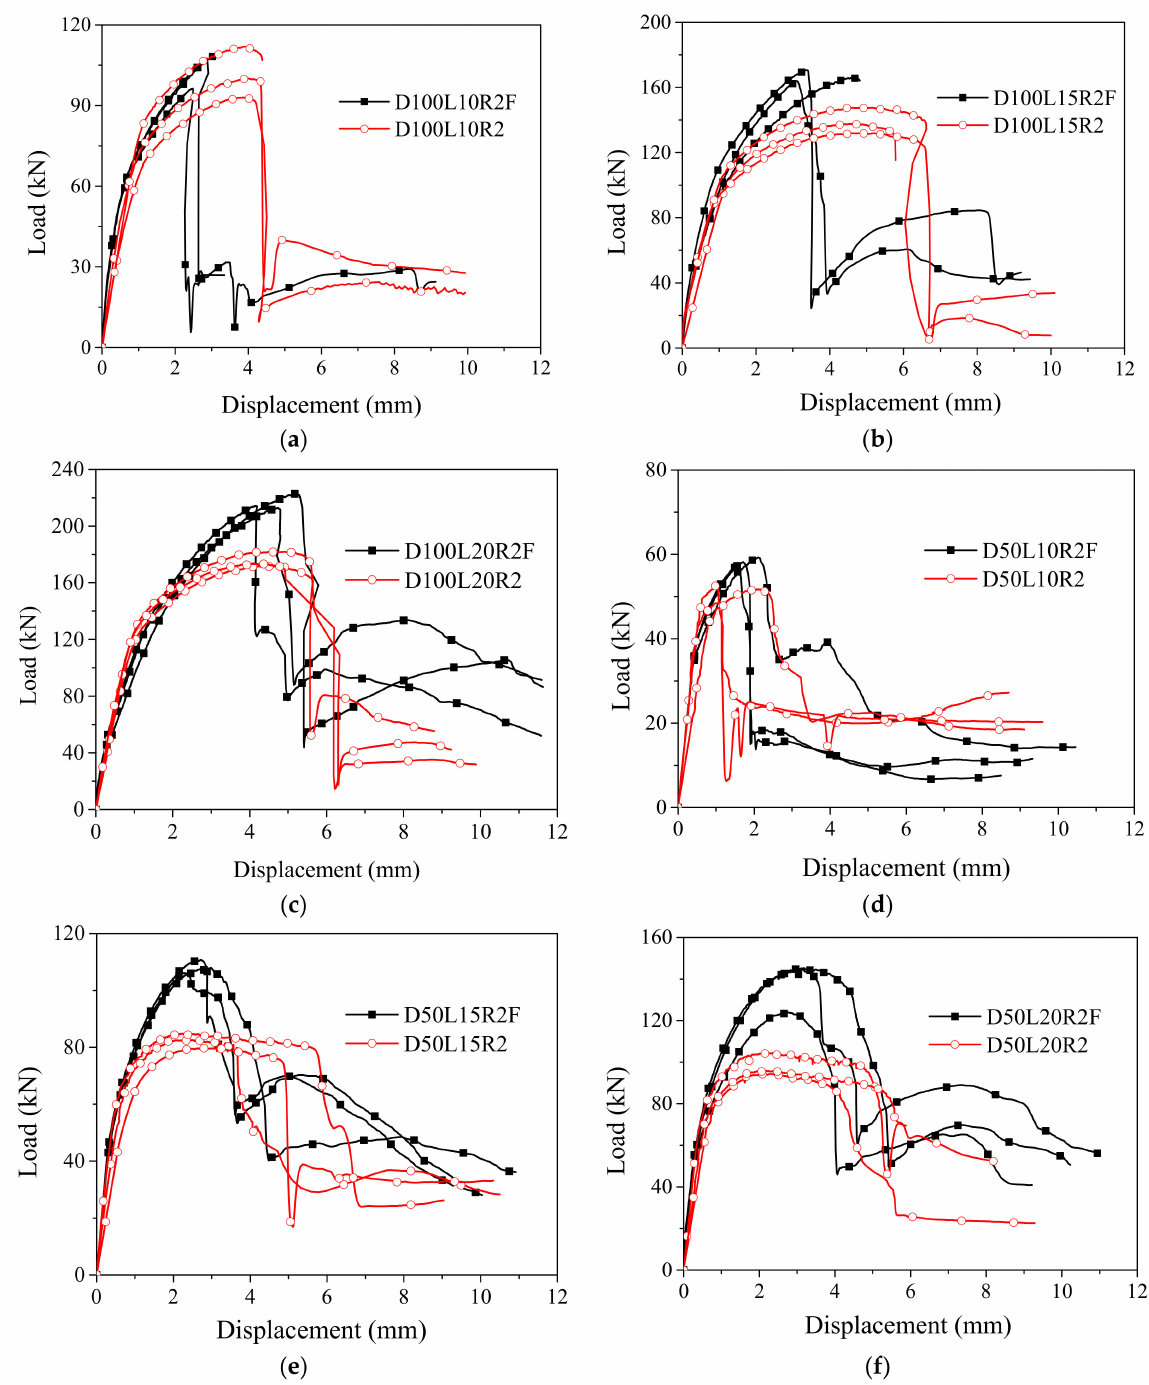
Figure 5. Comparison of load–displacement curves between foam-filled and unfilled bamboo com- posite tubes. ( a ) D100L10R2F; ( b ) D100L15R2F; ( c ) D100L20R2F; ( d ) D50L10R2F; ( e ) D50L15R2F; ( f )